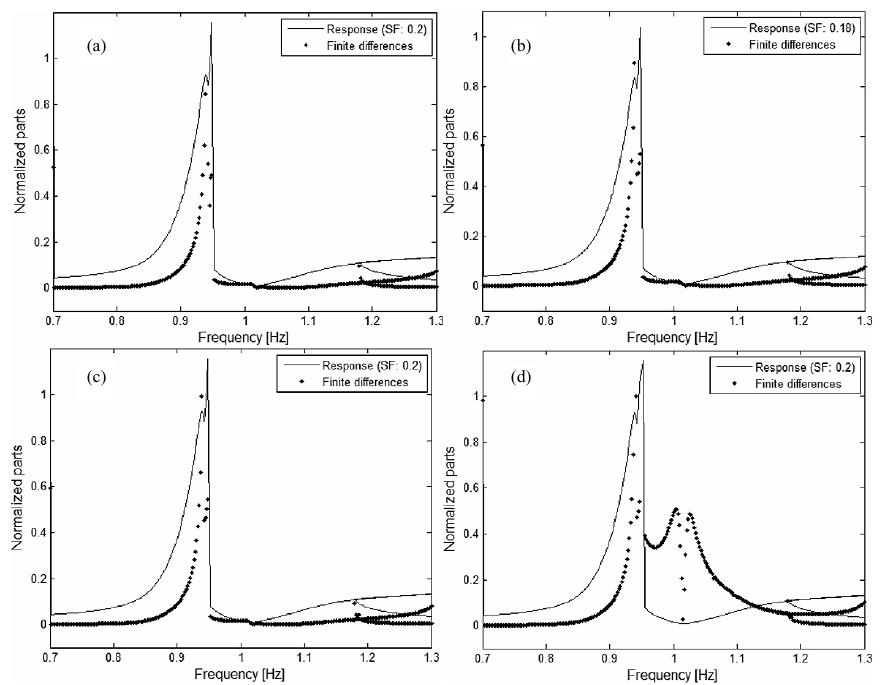
Fig. 4. Finite difference estimations of the Response H ( ω,p ) with respect to ξ 1 : (a) ∆ ξ 1 / ξ 1 = 1%; (b) ∆ ξ 1 / ξ 1 = 5%; (c) ∆ ξ 1 / ξ 1 = 10%; (d) ∆ ξ 1 / ξ 1 = 20%.